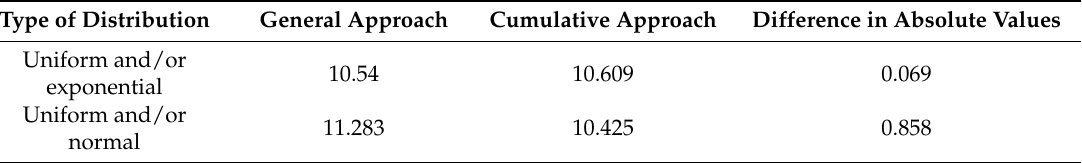
Table 10. Comparison of estimated total number of contactor trips per